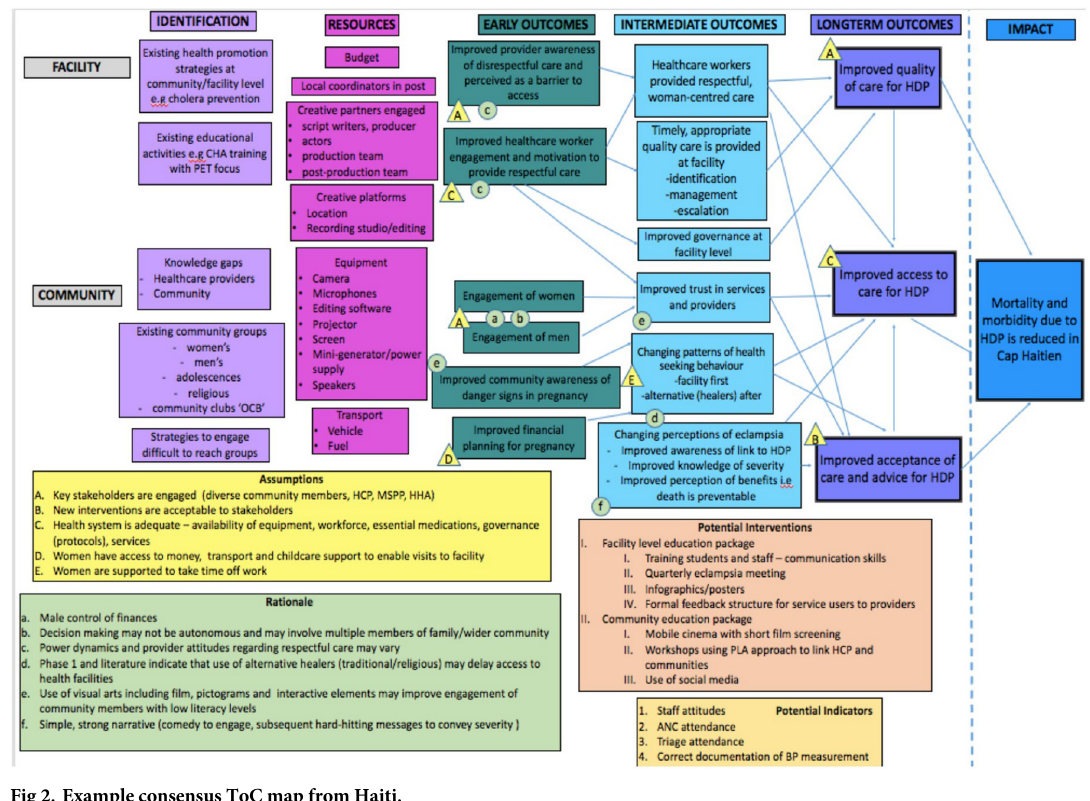
Fig 2. Example consensus ToC map from